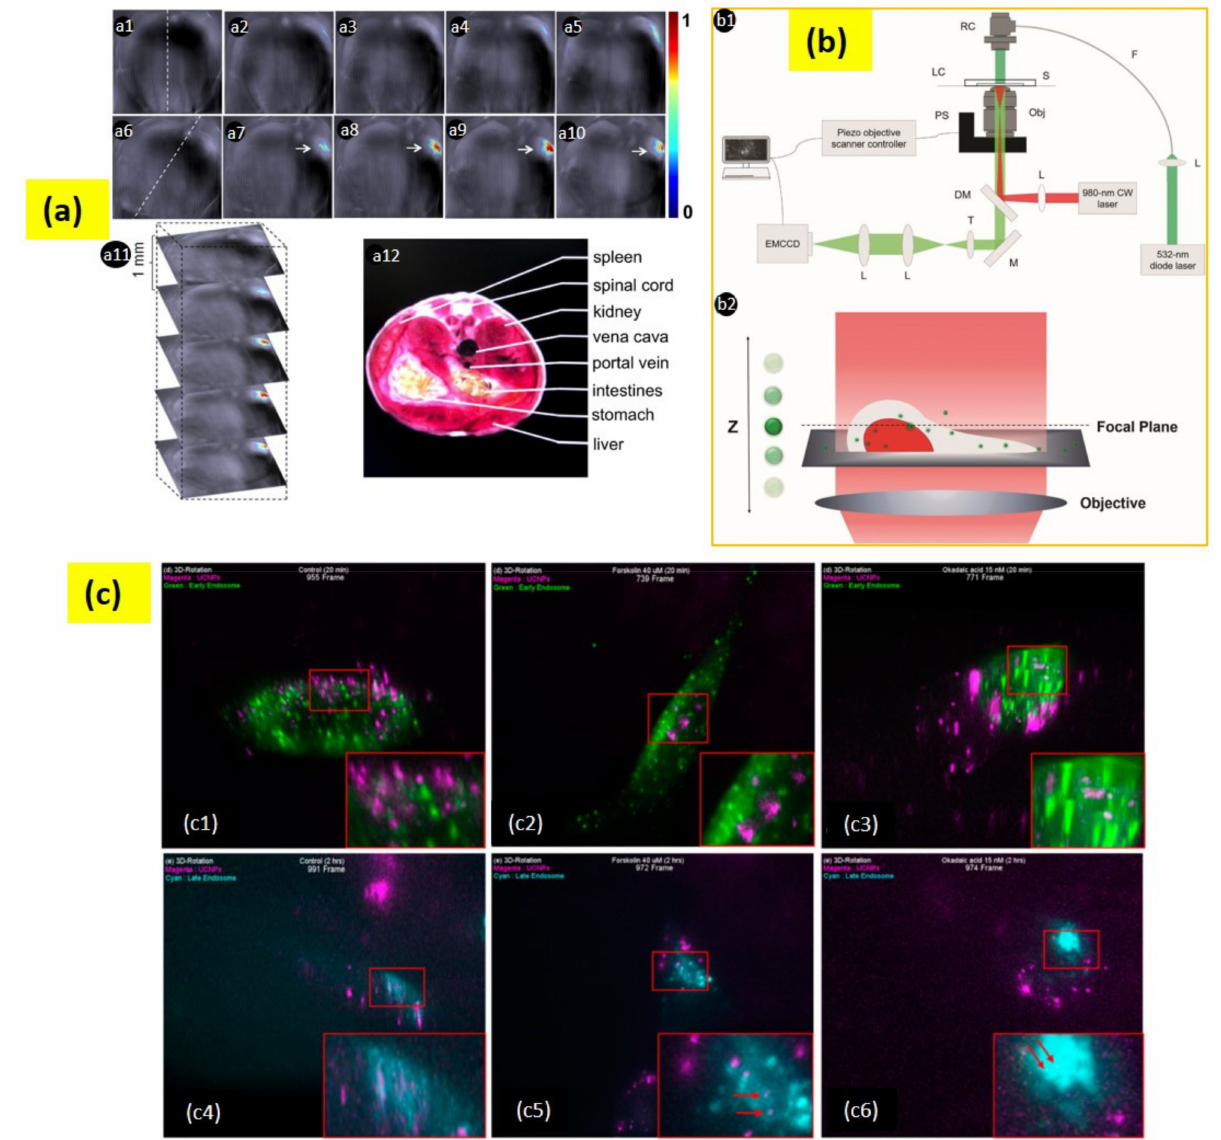
Figure 6. ( a ) ( a1 – a5 ) Live mouse anatomy sections prior to injection of UC- α -CD. ( a6 – a10 ) Anatomy sections after 35 min post-intravenous injection of UC- α -CD. Figure ( a1 , a6 ) with a dashed line indicates the mouse position. ( a7 – a10 ) suggests UC- α -CD localization. ( a11 ) Three-dimensional image collection. ( a12 ) Analyzed area related section. ( b ) ( b1 ) The setup for a wide-field epi-fluorescence microscopy. The 980 nm CW laser is the excitation source for UCNPs; the 532 nm diode laser is the light source for RFP; the acronyms used in the diagram are as follows:RC—reflective collimator; LC—live-cell chamber; S—sample; F—optical fiber; PS—piezo objective scanner; Obj—objective lens; L—lens; DM—dichroic mirror; T—tube lens; M—mirror. ( b2 ) Scheme for scanning of the objective lens. ( c ) Early state colocalizations of UCNPs with early endosomes or late endosomes in tau aggregated SH-SY5Y cell. ( c1 ) Control 20 min (955 frame), ( c2 ) forskolin 20 min (739 frame), (974 frame). Magenta: UCNPs; green: early endosome; cyan: late endosome. Adapted with permission from